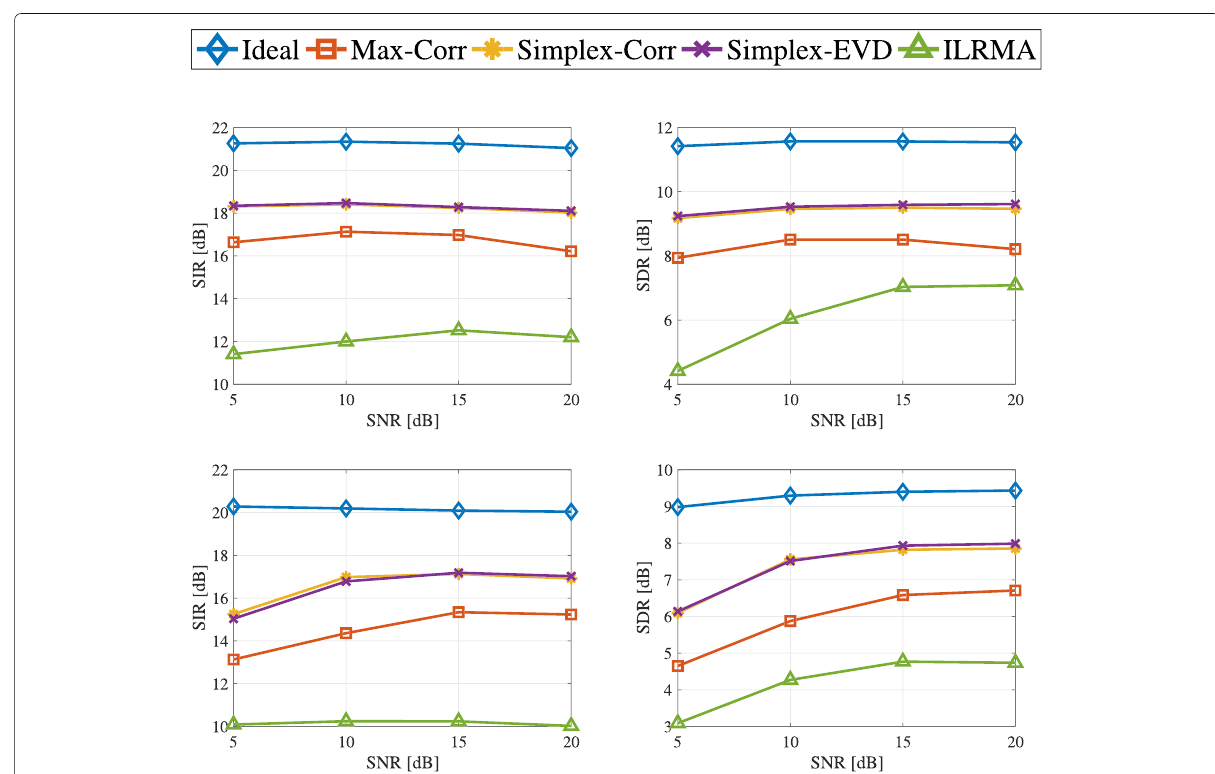
Fig. 6 ULA: evaluation for mixtures with J = 3 speakers with balanced activity—performance as a function of the SNR for a , b low and c , d high reverberation conditions